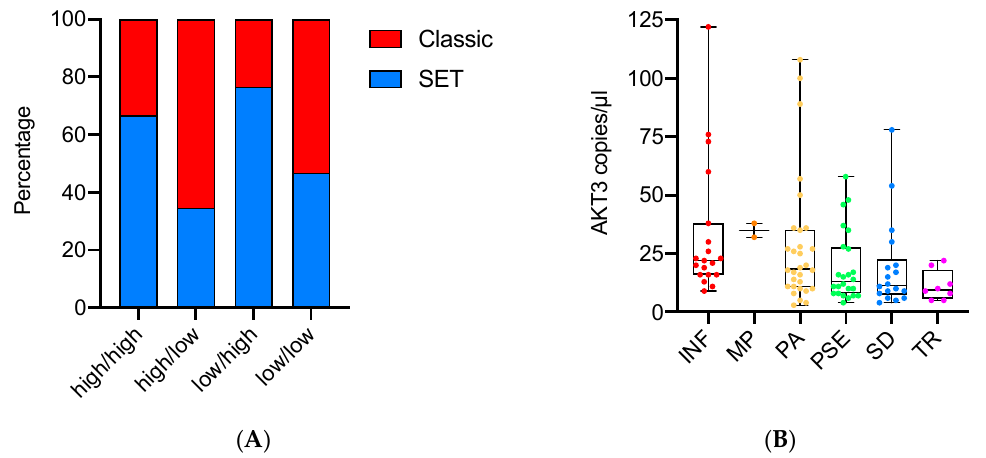
Figure 3. Association between AKT isoform expression categories and tumor morphology. ( A ) Bar chart plot showing the distribution of SET (solid, pseudo-endometrioid, transitional) and classic features among the four AKT classes; ( B ) box plots representing AKT3 expression among the six HGSOC growth patterns. INF—infiltrative; MP—micropapillary; PA—papillary; PSE—pseudo-endometrioid; SD—solid; TR—transitional-like.